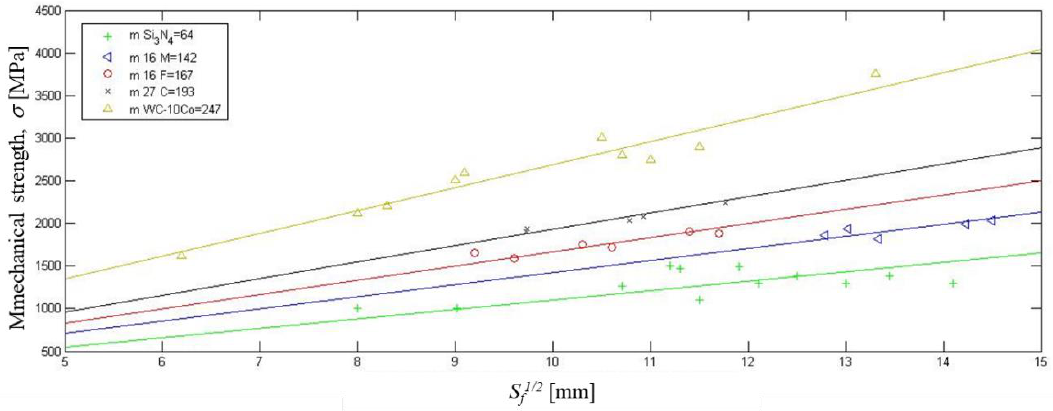
Figure 4. Relationship between the mechanical strength ( σ ) and the square root of the total fracture surface area ( S f 1 / 2 ) for specimens subjected to P4B tests. Note that the results for two new materials are included from references [21,22].